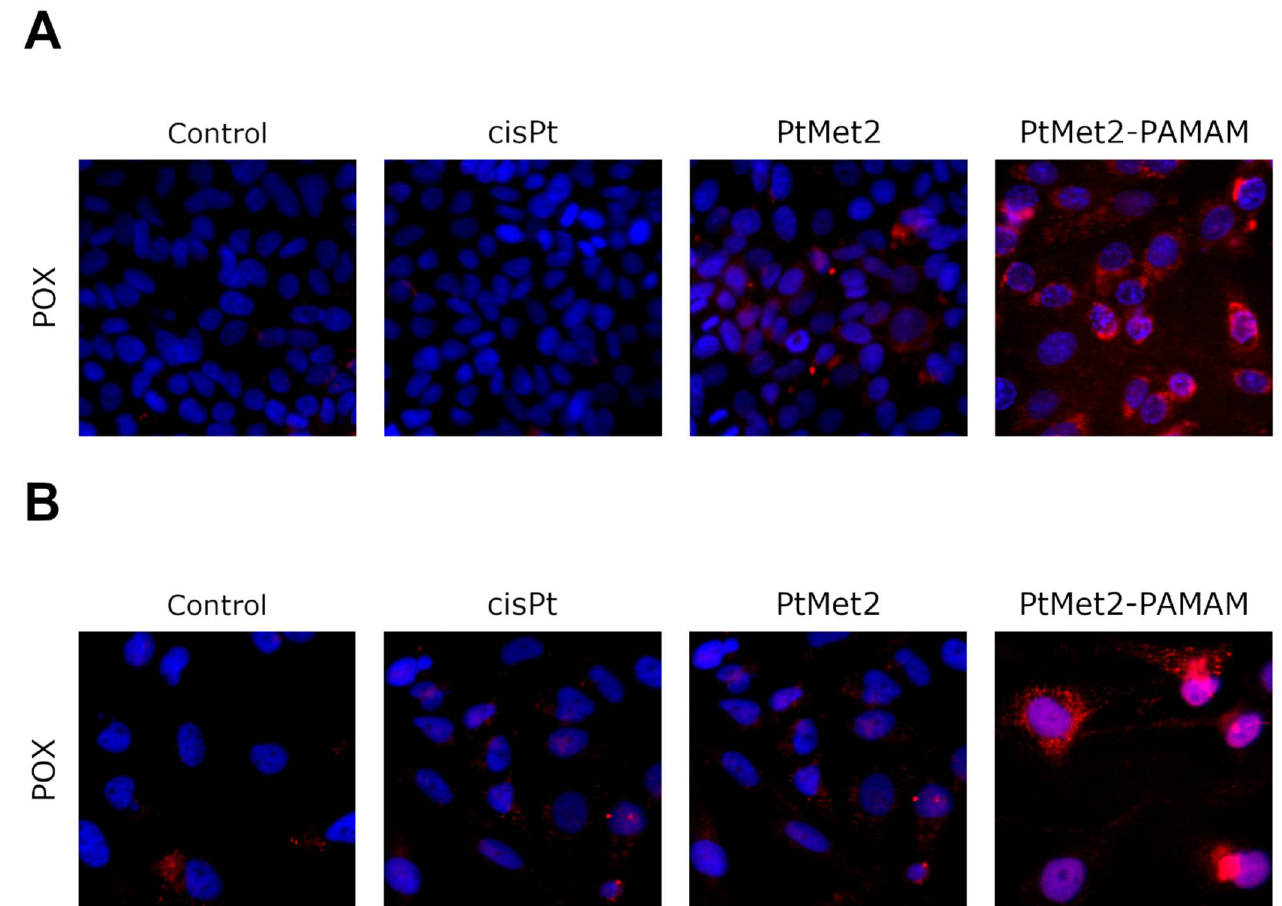
Figure 17. Expression and nuclear translocation of POX detected by fluorescence microscopy in MCF-7 ( A ) and MDA-MB-231 ( B ) breast cancer cells after treatment with PtMet2, PtMet2–PAMAM, and cisplatin (2.5 μM all of them) for 24 h. Representative photographs are shown.